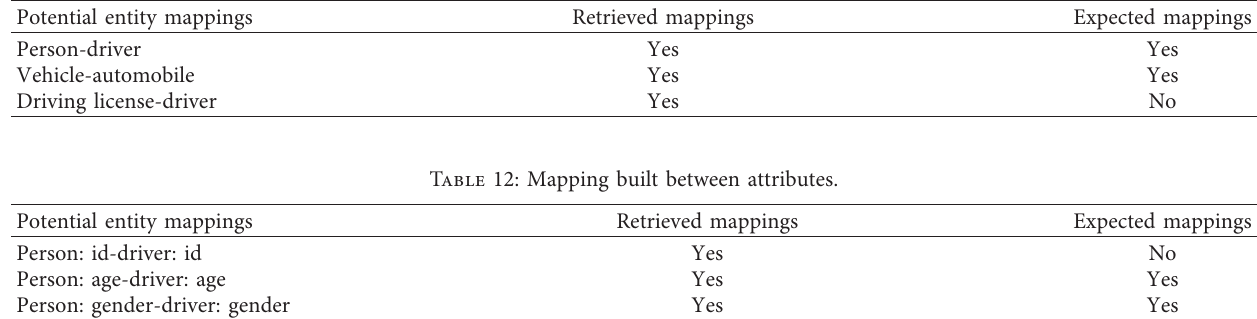
Table 11: Mapping built between classes.